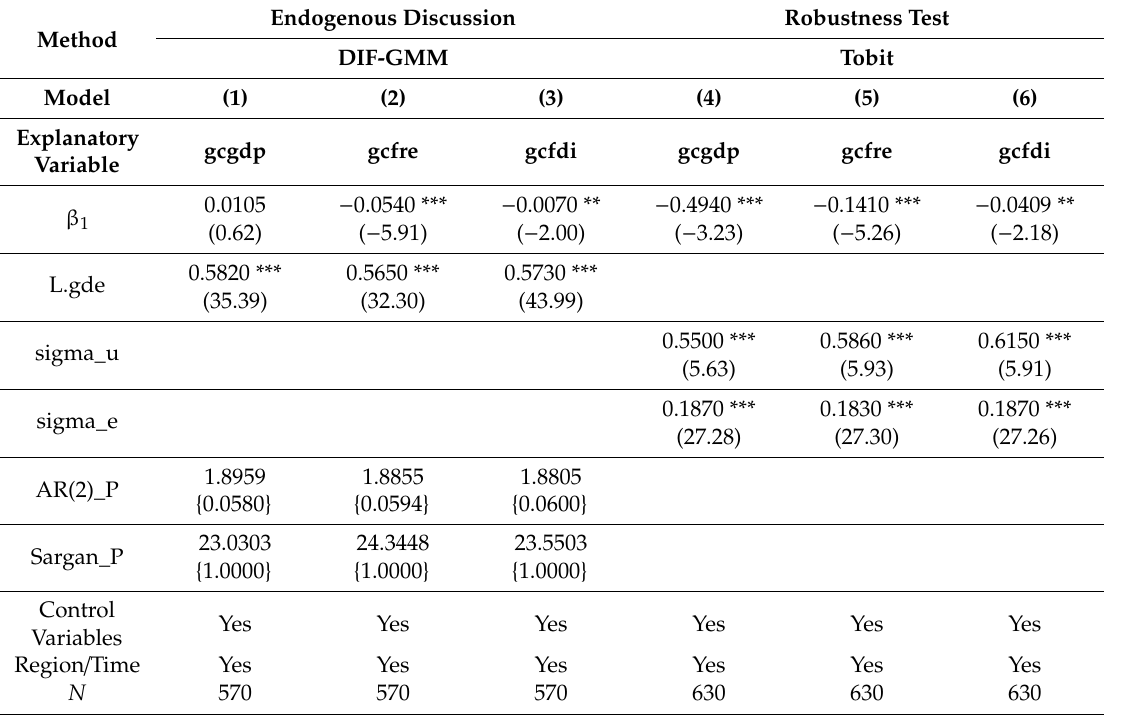
Table 6. Endogenous and robustness regression